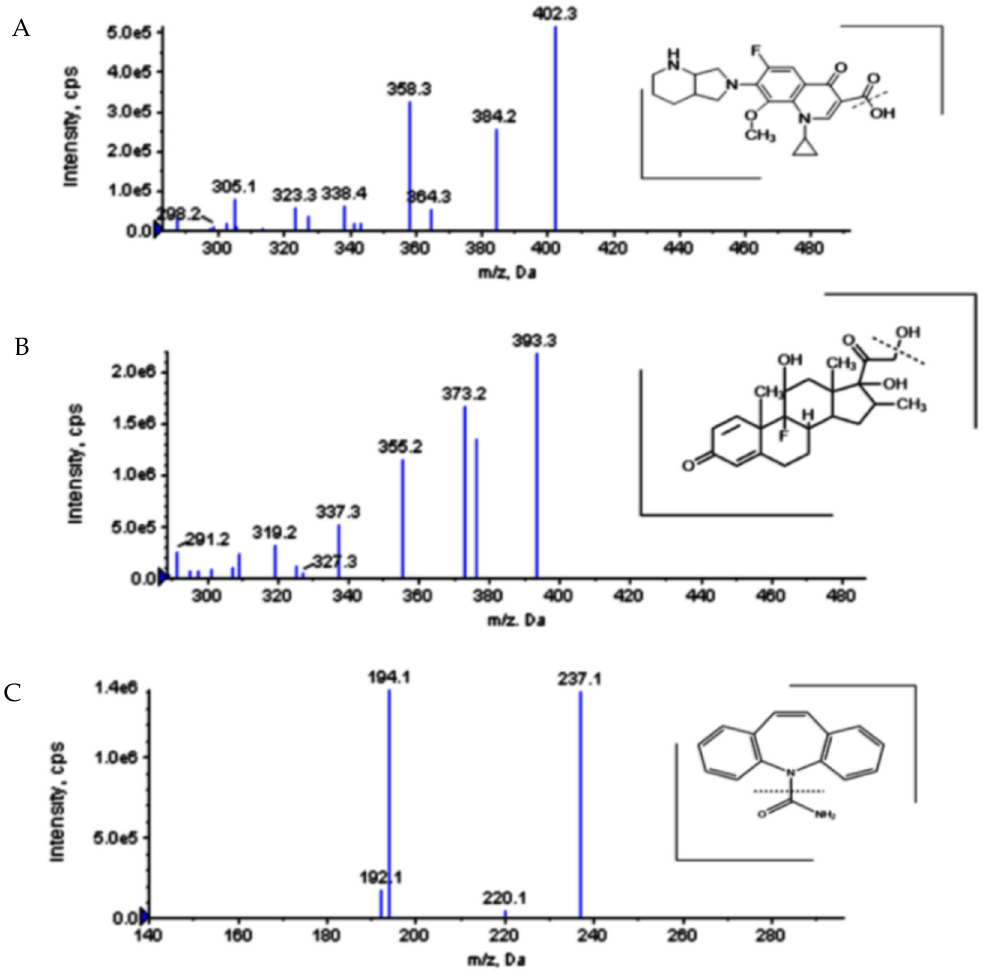
Figure 2. Production spectra ( MS / MS ) of moxifloxacin hydrochloride ( A ) ( m / z 402.3 > 384.2), dexamethasone sodium phosphate ( B ) ( m / z 393.3 > 373.2), and internal standard ( C ) ( m / z 237.1 > 194.1) with their possible fragmentation.